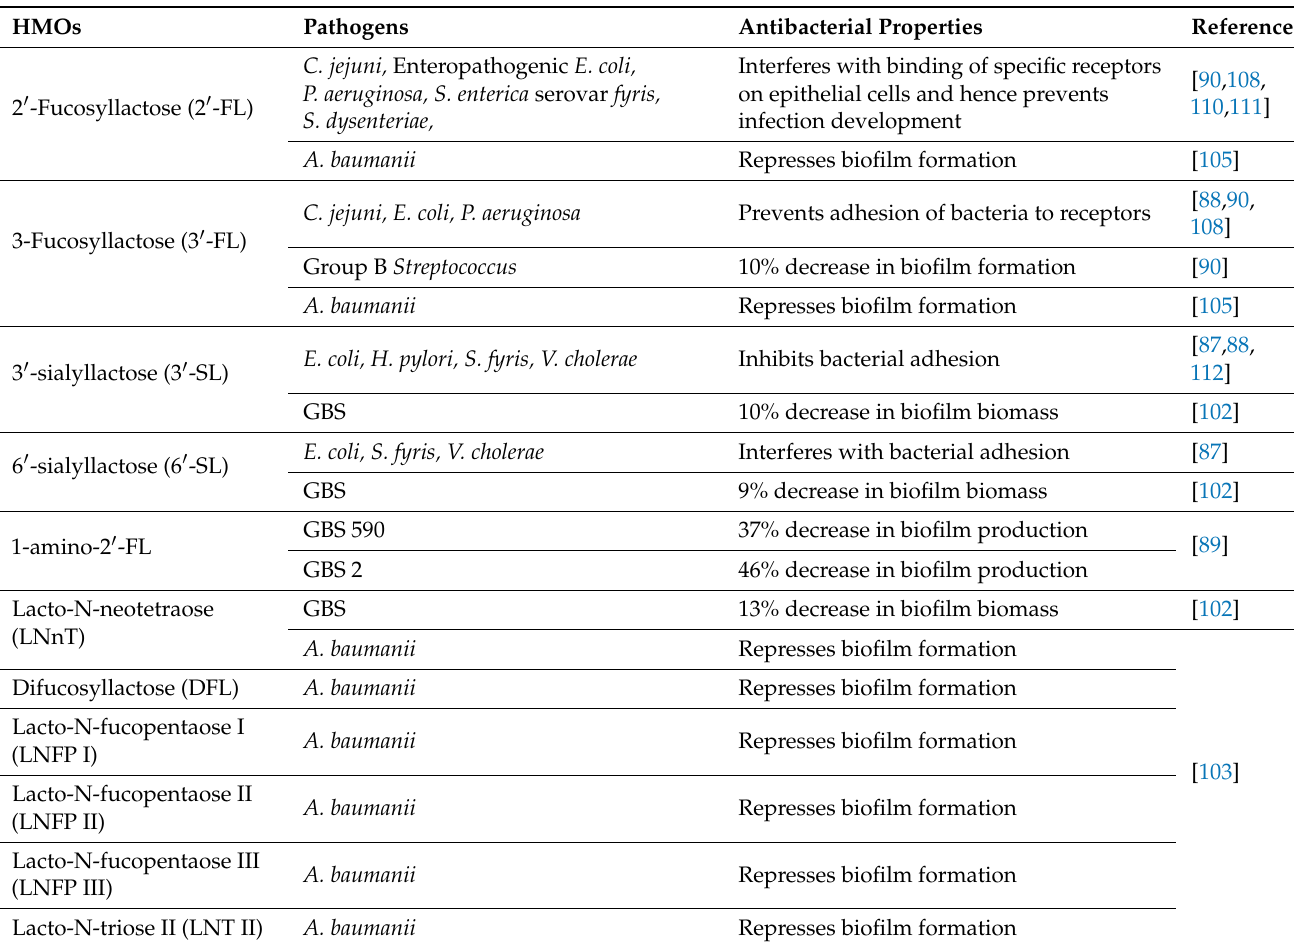
Table 2. Antibacterial and antibiofilm activity of major HMO